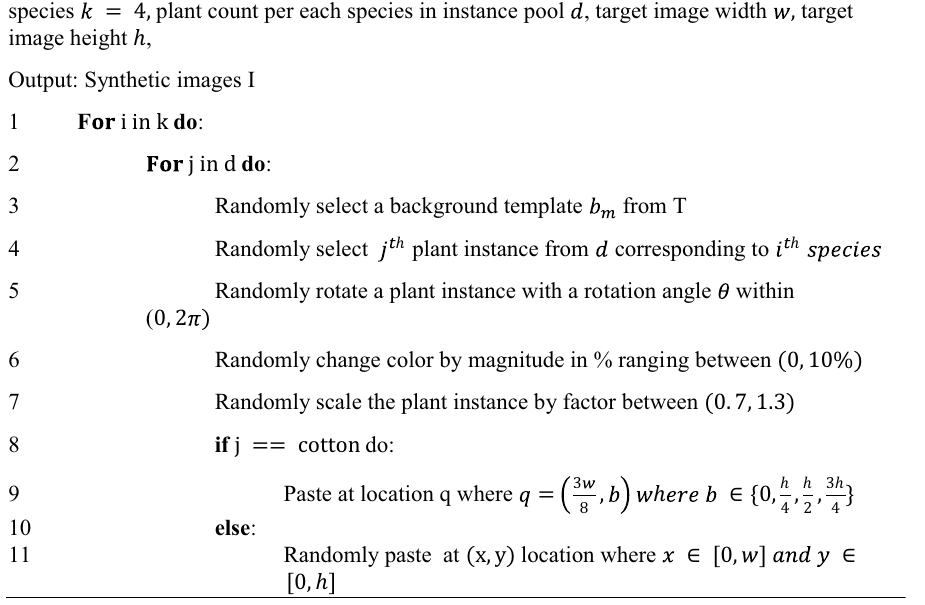
Algorithm 1: Row-oriented synthetic image generation